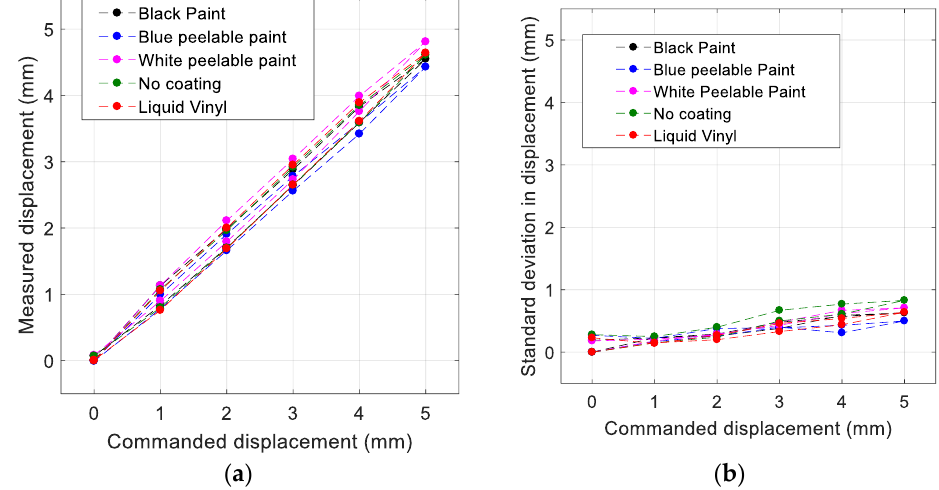
Figure 4 . Results for solid rigid displacement test for different coatings. ( a ) Mean displacement. ( b ) Standard deviation .